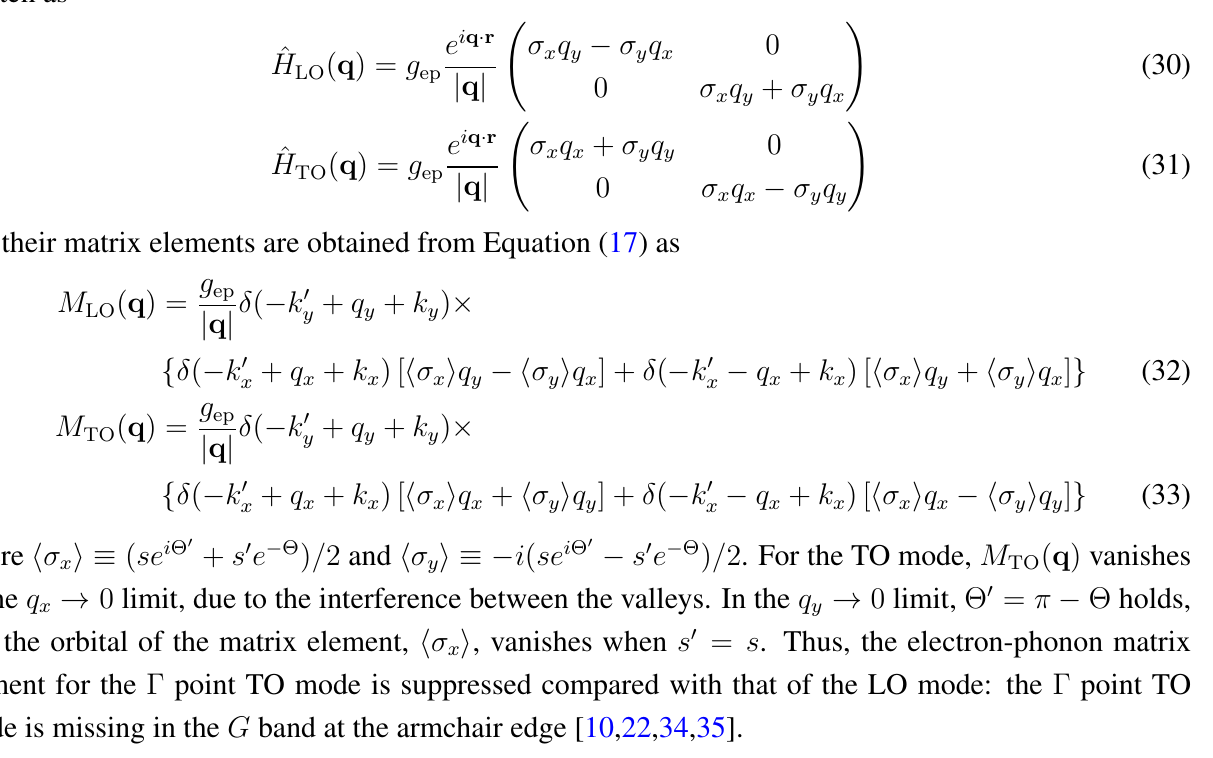
( q, ω ) . The variables ~ v (cid:22) D